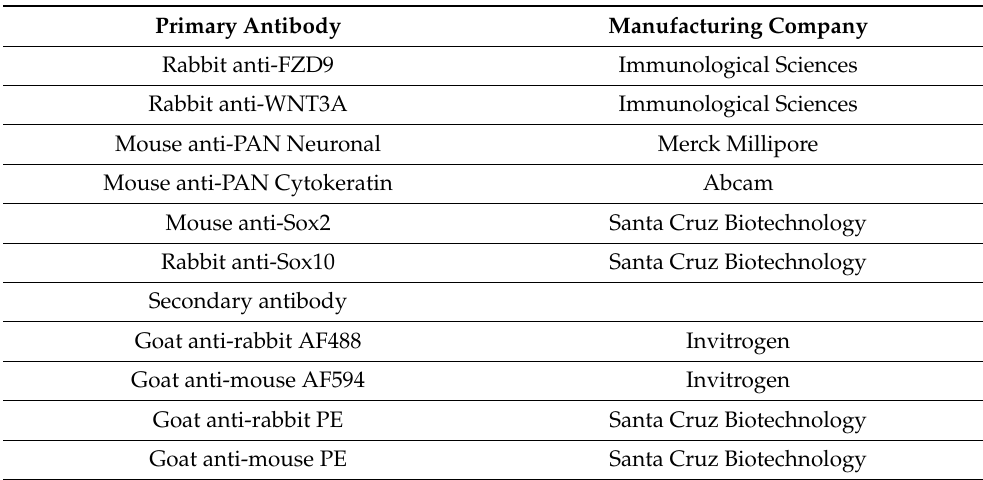
Table 1. Antibodies used in flow cytometry and immunofluorescence studies to investigate the effects of STW 5 in zebrafish IBS. Due to the high genomic similarity of zebrafish with human, with zebrafish sharing 70% of their genes with humans, anti-human antibodies were used to detect fish markers when no specific antibodies were available. AF: Alexa Fluor; FZD9: Frizzled 9, a Wnt- signaling receptor; PAN cytokeratin: epithelial cell marker; PAN neuronal: neurofilament marker; PE: phycoerythrin; Sox2: transcription factor; WNT: signaling protein involved in